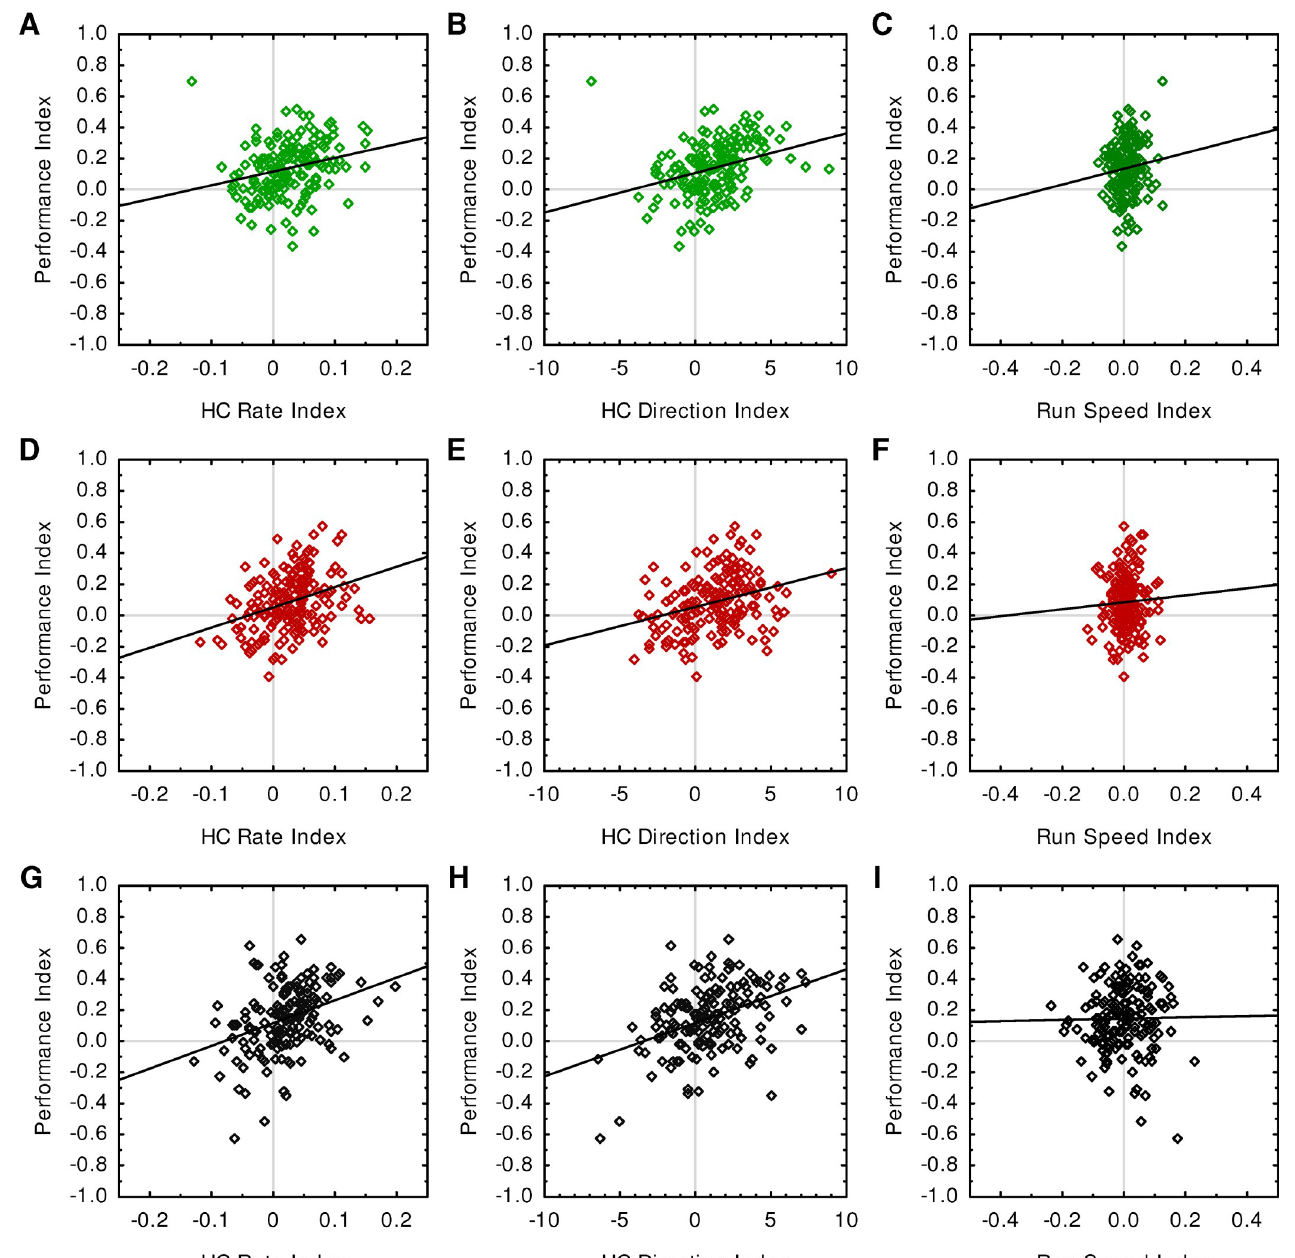
Fig 2. Modulations of HC rate and HC direction are correlated with memory strength. (A-C) For the experiment with varied sugar concentration, memory strength as measured by the Performance Index is positively correlated with (A) the HC Rate Index (Spearman, r S = 0.33, p < 0.00001) and (B) the HC Direction Index (Spearman, r S = 0.42, p < 0.00001), but not with (C) the Run Speed Index (Spearman, r S = 0.09, p = 0.228). N = 166 each. (D-F) As in A-C, but for the experiment with varied odour concentration (Spearman, [D] r S = 0.33, p < 0.00001; [E] r S = 0.32, p < 0.00001; [F] r S = 0.05, p = 0.533; N = 170 each). (G-I) As in A-C, but for the experiment with varied number of training trials (Spearman, [G] r S = 0.37, p < 0.00001; [H] r S = 0.39, p < 0.00001; [I] r S = 0.1, p = 0.196; N = 156 each).